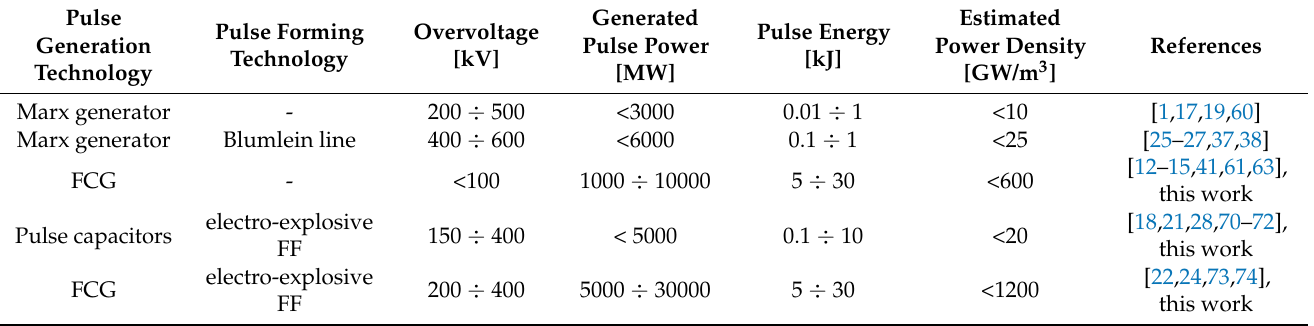
Table 5. Pulse generation and forming systems parameters—various technologies parameters